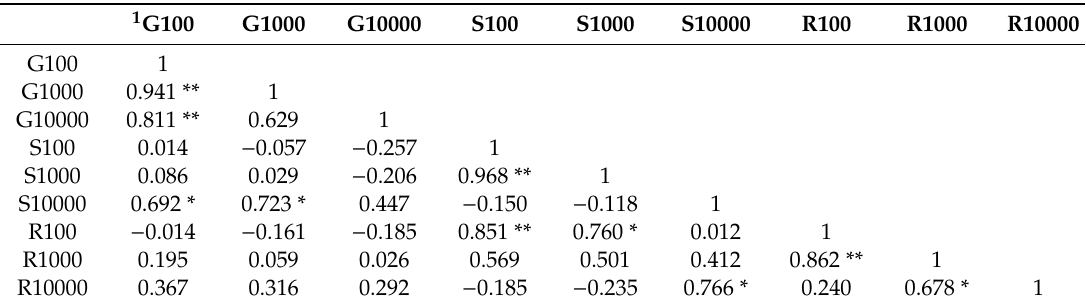
Table 3. Pearson correlation coe ffi cients (r) between seed germination (%), shoot length (cm), and root length (cm) at di ff erent concentrations of M. sacchariflorus extracts.